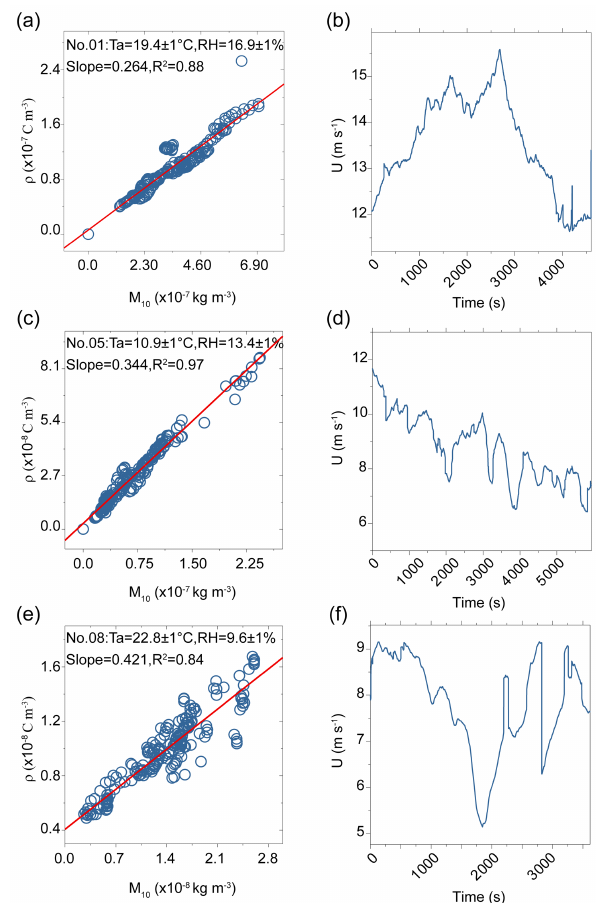
Figure 4. Significant linear relationships between the 10min mov- ing average of space charge density and dust concentration at the given ambient temperature and RH. In panels (a) , (c) and (e) , cir- cles denote the data obtained from observations, and straight lines denote the linear regression. The slopes corresponds to the scaled charge-to-mass ratios µ ∗ . Panels (b) , (d) and (f) show wind speed during the corresponding period of (a) , (c) and (e)